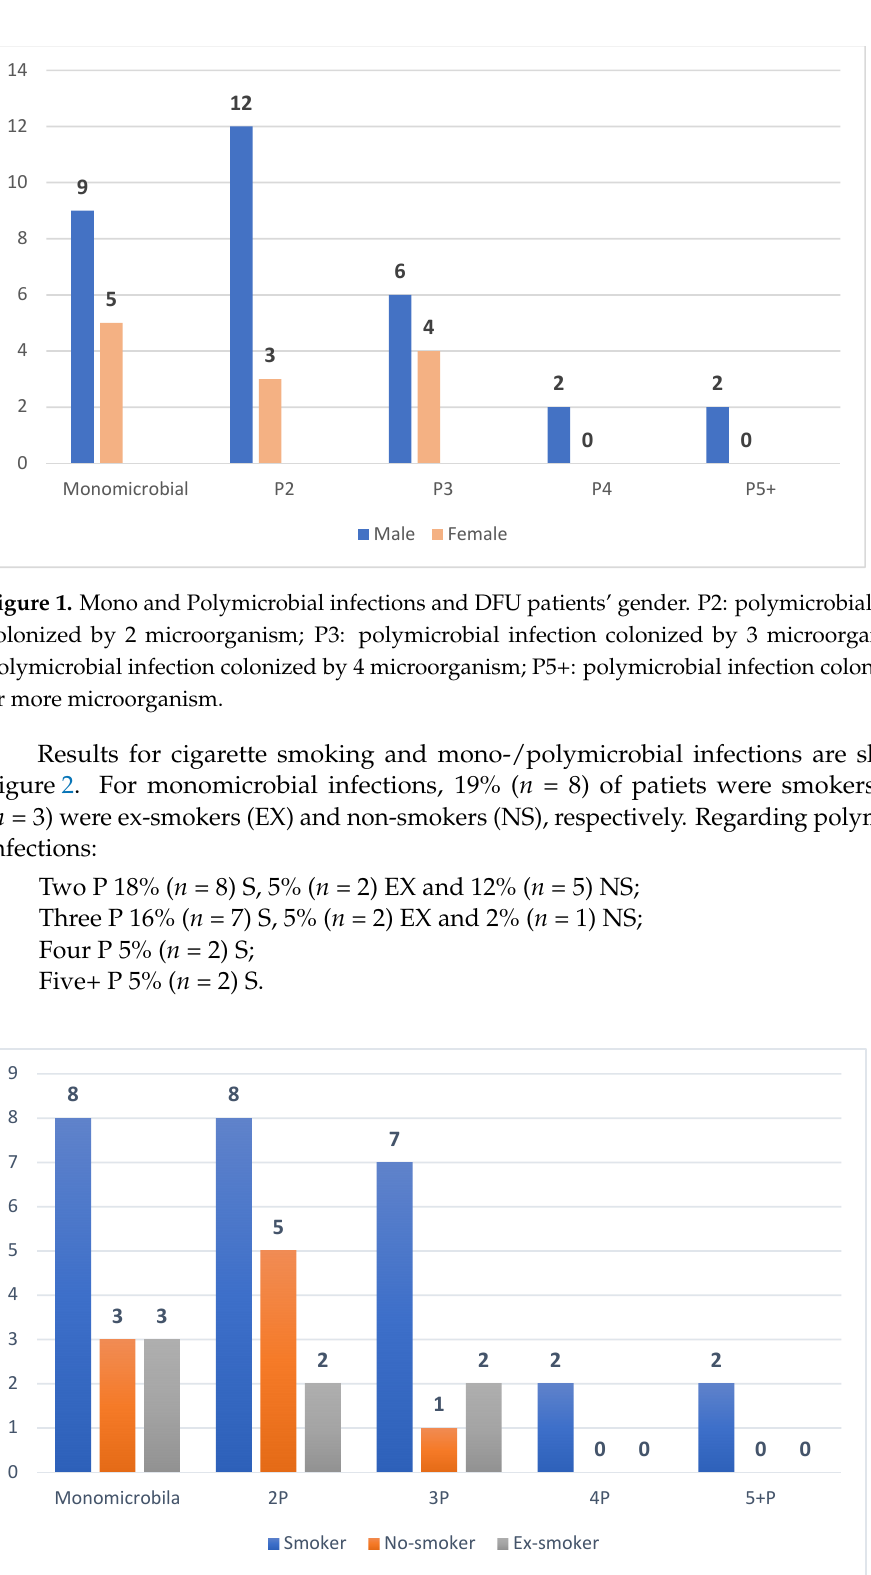
Figure 3. Monomicrobial and polymicrobial infections and DFU patient lifestyle: BMI. P2: polymi ‐ crobial infection colonized by 2 microorganisms; P3: polymicrobial infection colonized by 3 micro ‐ organisms; P4: polymicrobial infection colonized by 4 microorganisms; P5+: polymicrobial infection colonized by 5 or more microorganisms. Lastly, monomicrobial infections on comorbidities revealed that 5% ( n = 2) had no NuD, 7% ( n = 3) had one NuD, 5% ( n = 2) had two NuD, 7% ( n = 3) had three NuD, and 9% ( n = 4) had four NuD. In polymicrobial infections NuD distribution was: ‐ TwoP, 2% ( n = 1) had no NuD, 7% ( n = 3) had one NuD, 15% ( n = 6) had two NuD, 5% ( n = 2) had three NuD, and 7% ( n = 3) had four NuD; for a total of 36% ( n = 15); ‐ ThreeP 5% ( n = 2) have no NuD, 7% ( n = 3) have one NuD, 2% ( n = 1) have two NuD, 5% ( n = 2) have three NuD, 2% ( n = 1) have four NuD, and 2% ( n = 1) have five NuD. For a total of 23% [ n = 10]; ‐